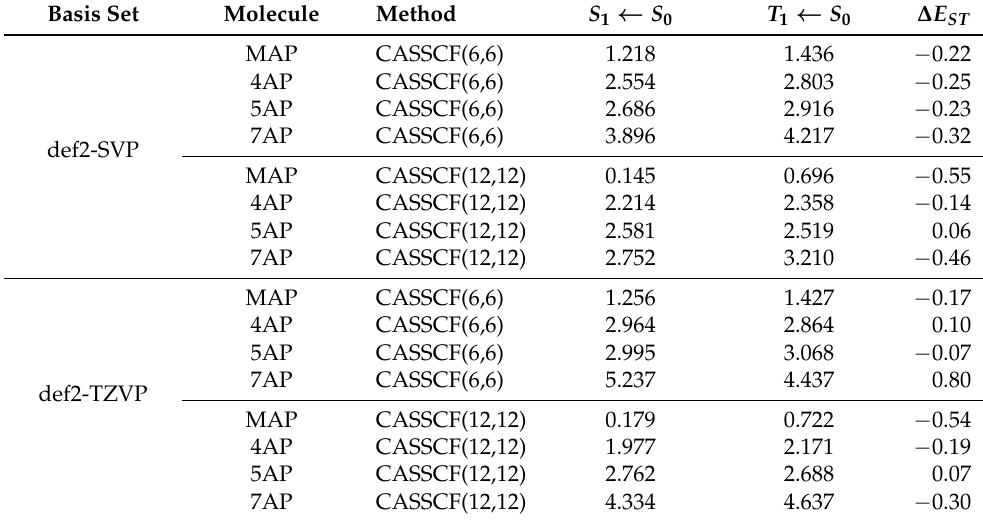
Table 2. Excited-state energies and associated ∆ E ST energy difference (all in eV) calculated with the CASSCF